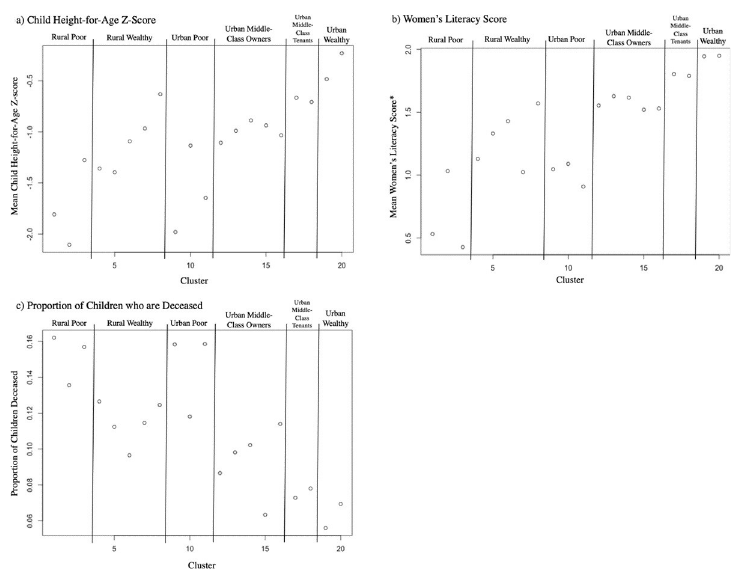
Fig 3. Mean child height-for-age Z-score, women’s literacy score, and proportion of children who are deceased by Cameroonian EconomicCluster. Caption: †Literacy Score: 0 = “Cannot read at all”, 1 = “Able to read only parts of a sentence”, 2 = “Able to read whole